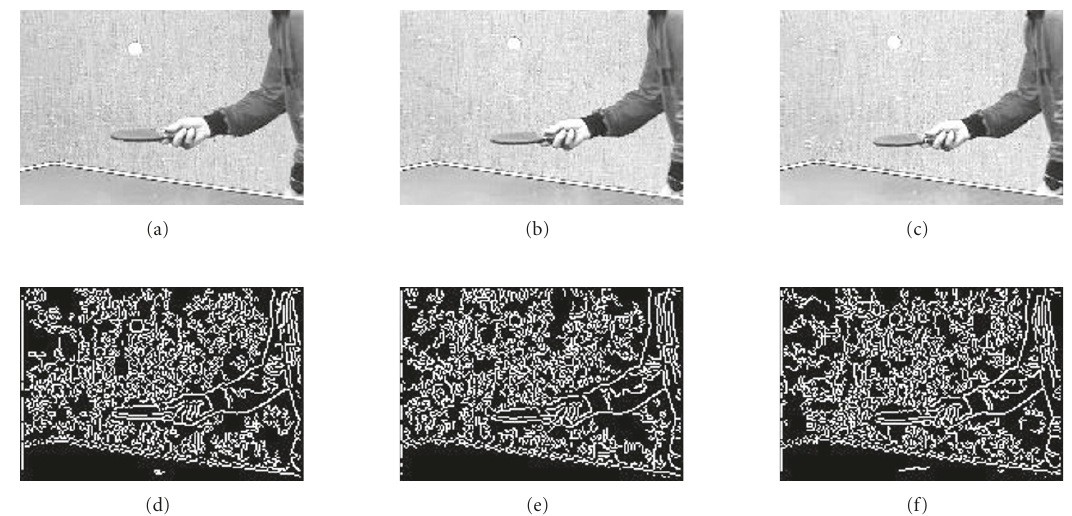
Figure 3: Video sequence of a table tennis player coming forward with his bat going down and ball going up at time t = 2,3,4. (a)–(c) Image frames. (d)–(f) Edge output.